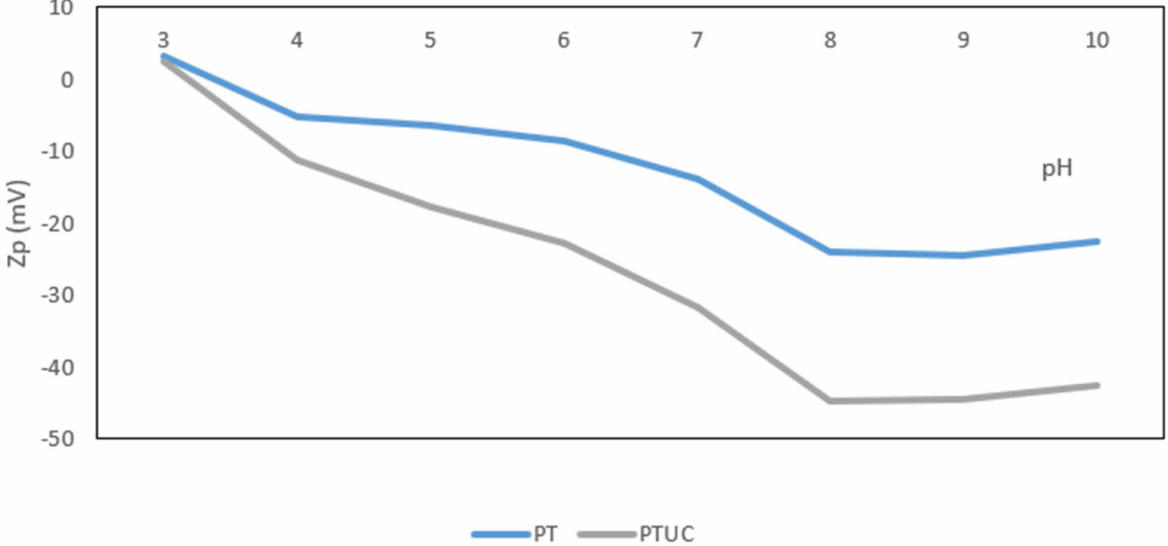
Figure 2. pH dependence of zeta potential for unmodified membrane (PT) and the membrane modified with sawdust-derived cellulose nanocrystals (PTUC). The figure shows a change in the surface charge as a result of the modification.